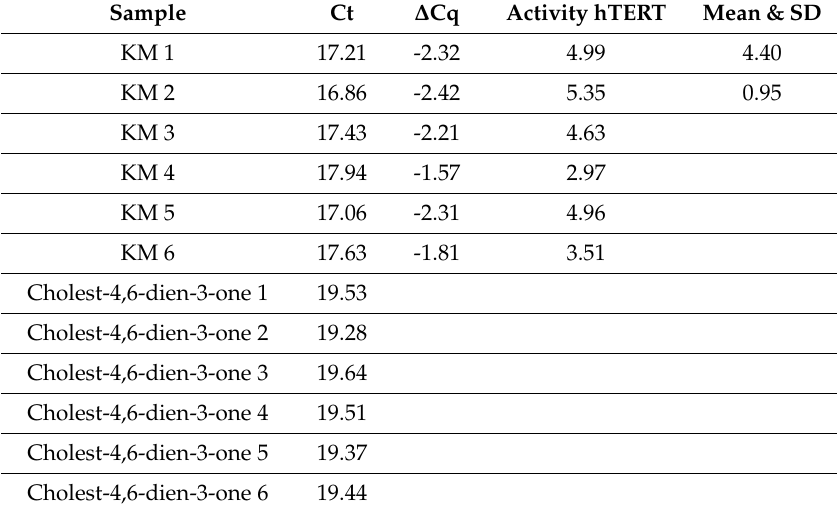
Table 1. Cholest-4,6-dien-3-one induced a four-fold reduction of telomerase activity in hBTSC cultures when compared to hBTSCs cultured in basal condition (KM). ∆ Cq is quantification cycle value obtained from